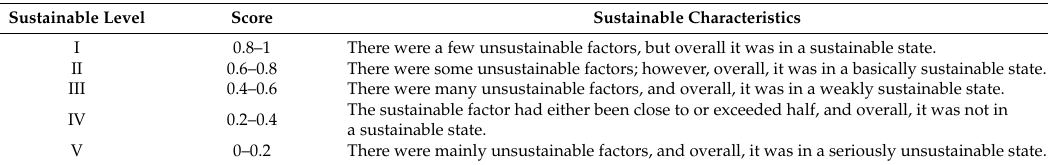
Table 4. Sustainable energy supply level table.